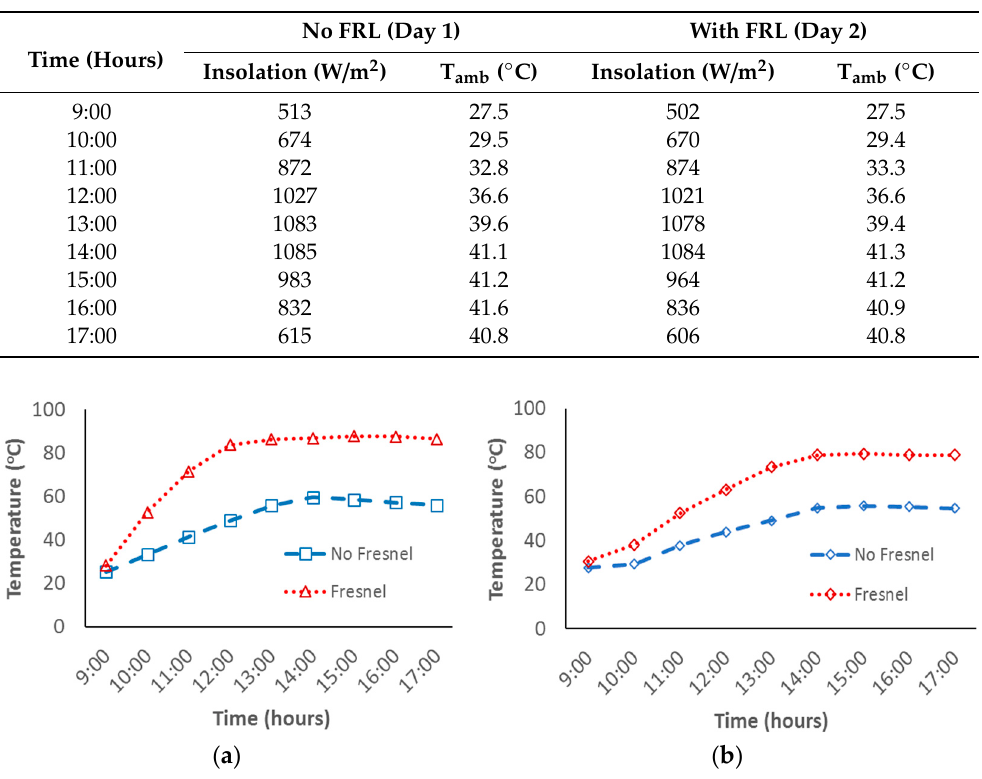
Figure 4. The measured temperatures during experiments ( a ) water temperature, ( b ) glass temperature.